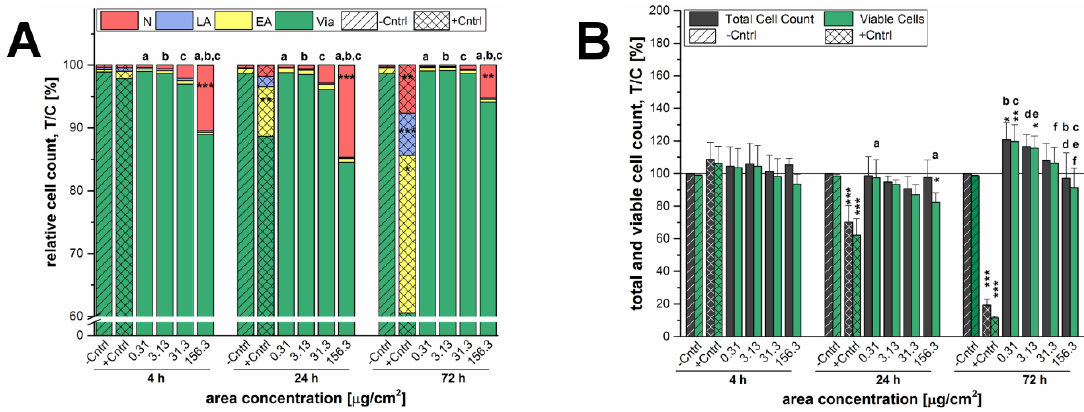
Figure 3. Influence of 200 nm SiO 2 particles on cell proliferation and cell death of GXF251L cells monitored microscopically after an incubation period of 4 h, 24 h and 72 h. Staurosporine (800 nM) was applied as a positive control (+Cntrl) resulting in apoptotic and necrotic cell death. ( A ) Viable (Via), early apoptotic (EA) and late apoptotic (LA), as well as, necrotic cells (N) are plotted in relation to the total cell count; ( B ) The depicted bars represent the total cell counts and the respective amount of viable cells. Total cell count was quantified in relation to the negative control (−Cntrl). Cell viability was quantified in relation to the viability of the negative control, as well as, the total cell count of the negative control (T/C [%]). The solid line represents the negative control set to 100%. Statistical analysis was performed by One-way ANOVA followed by Fisher’s LSD test. Significances indicated as * refer to a comparison to the respective negative control (* ≡ p ≤ 0.05; ** ≡ p ≤ 0.01 and *** ≡ p ≤ 0.001; n ≥ 3). The same letters indicate a significant difference of these data (in ( A ): refers to necrotic cells only) with a statistical level of at least p ≤